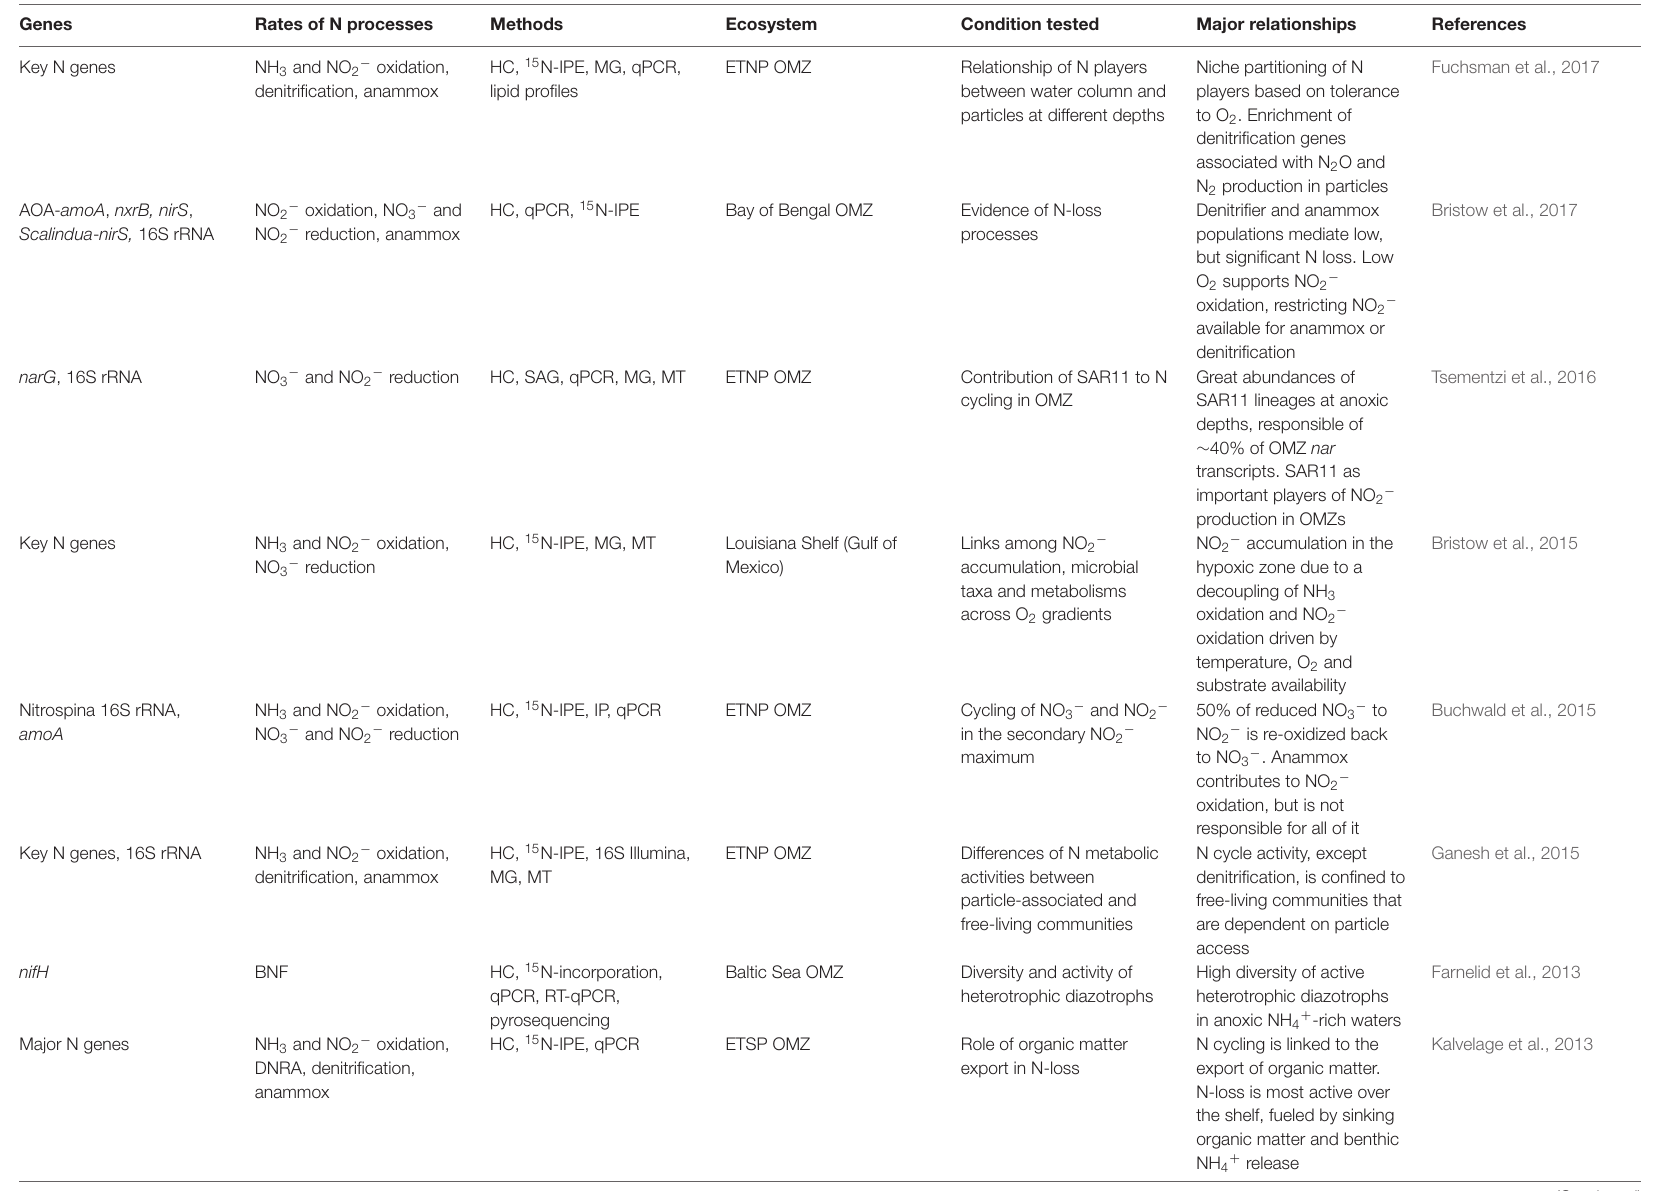
TABLE 1 | Representative studies using N cycling genes and rate measurements of N processes in marine ecosystems: ocean minimum zones, open ocean, deep-sea, and estuarine